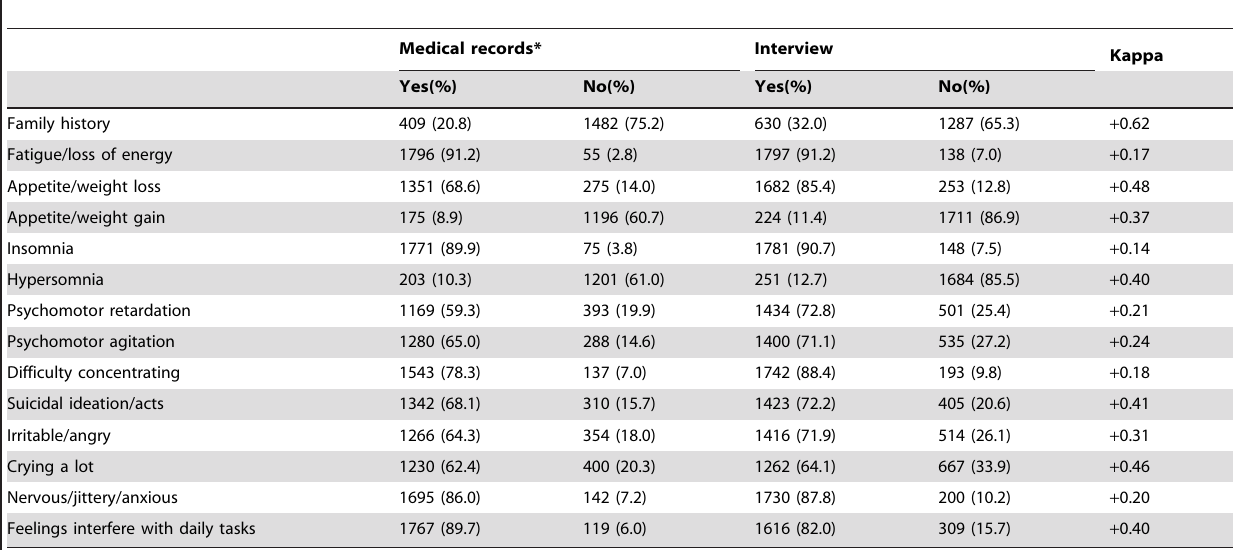
Table 2. Correlation between clinical features of major depression obtained from a structured interview and medical records.